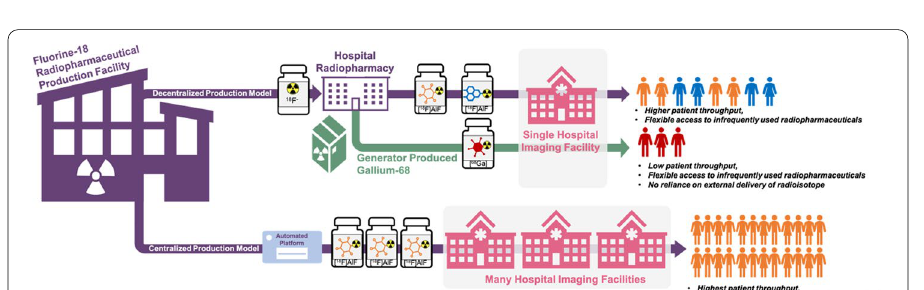
Fig. 11 Structures of A [ 18 F]AlF-pentixather derivatives and B [ 18 F]AlF-NOTA-T140